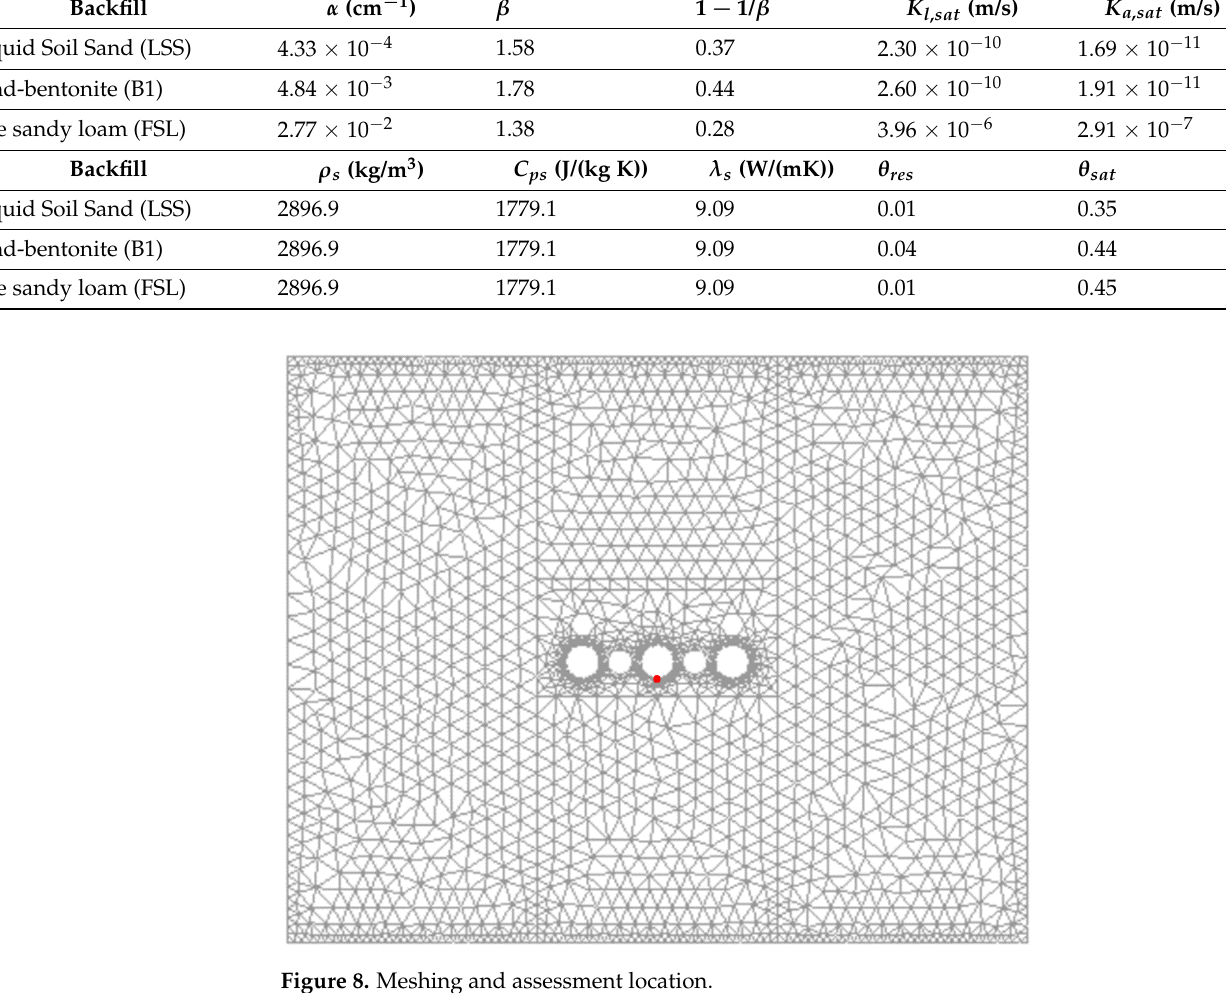
Table 9. Thermal and hydraulic properties of backfill materials (adopted from [39 – 41]).